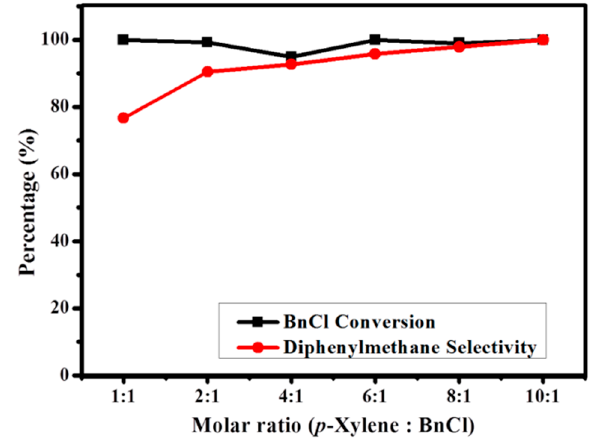
Figure 4. The effects of the molar ratio of p-xylene to BnCl on the Friedel–Crafts alkylation reaction (under a 5c catalyst dosage of 1.0 mole %, a reaction time of 0.5 h, and a reaction temperature of 80